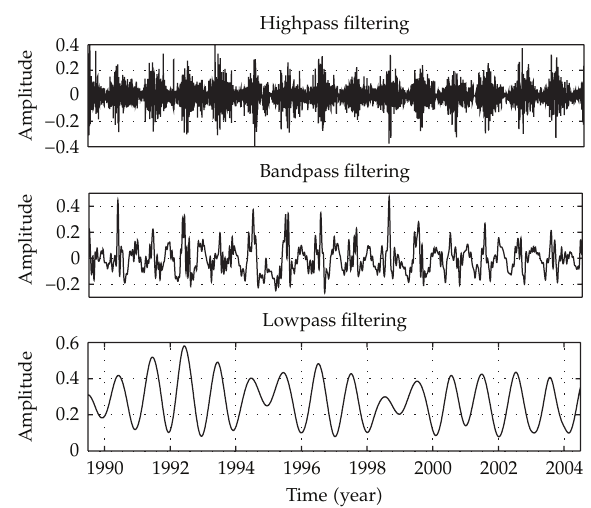
Figure 4: Three subband signals obtained by applying BEMD on daily evaporation